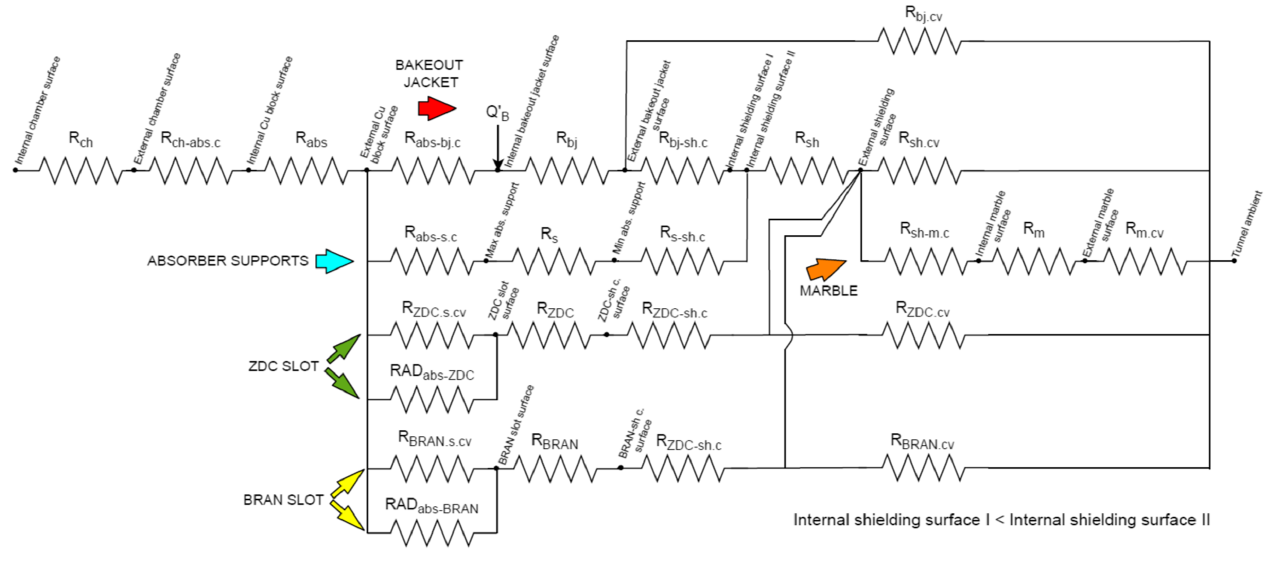
FIG. 7. Resistance diagram of the bakeout system.